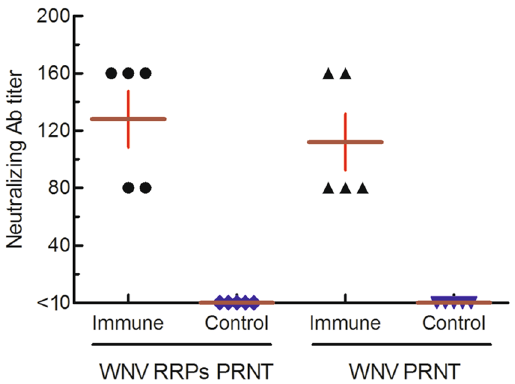
Figure 7. Mouse sera neutralizing antibody detected by PRNT with Δ WNV-GFP and the WNV native virus. The dark red horizontal lines represent the average neutralizing antibody titre.